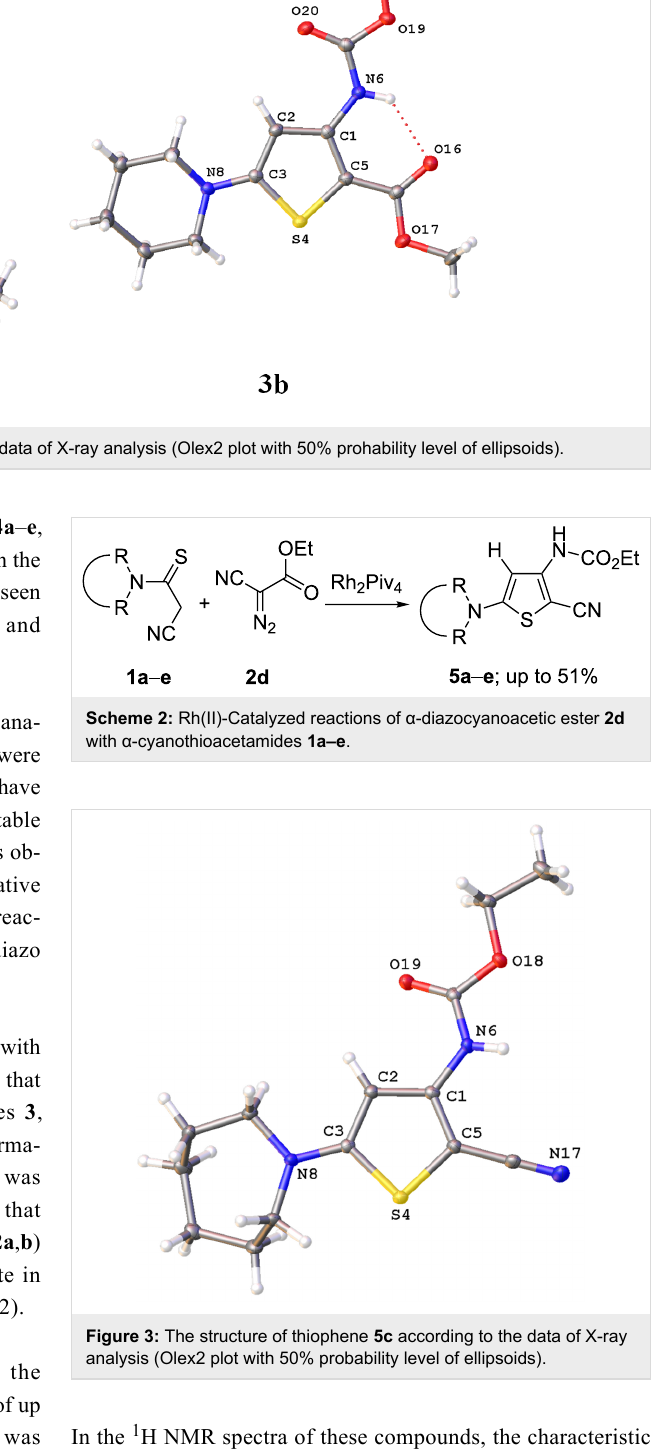
In the 1 H NMR spectra of these compounds, the characteristic signals of NH protons are observed in the range of 7.15–7.09 ppm for 5a – e . The signals of thiophene H-4 and